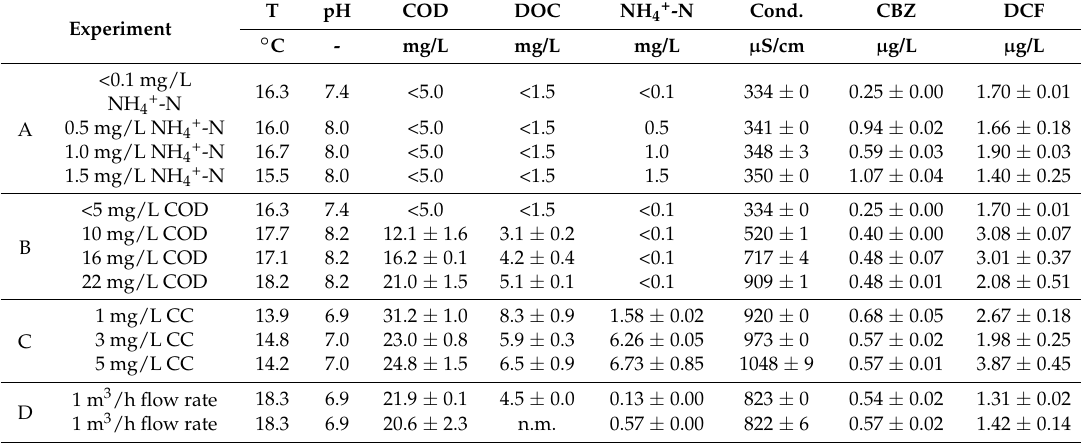
Table 1. Initial parameter values c 0 measured in the reference